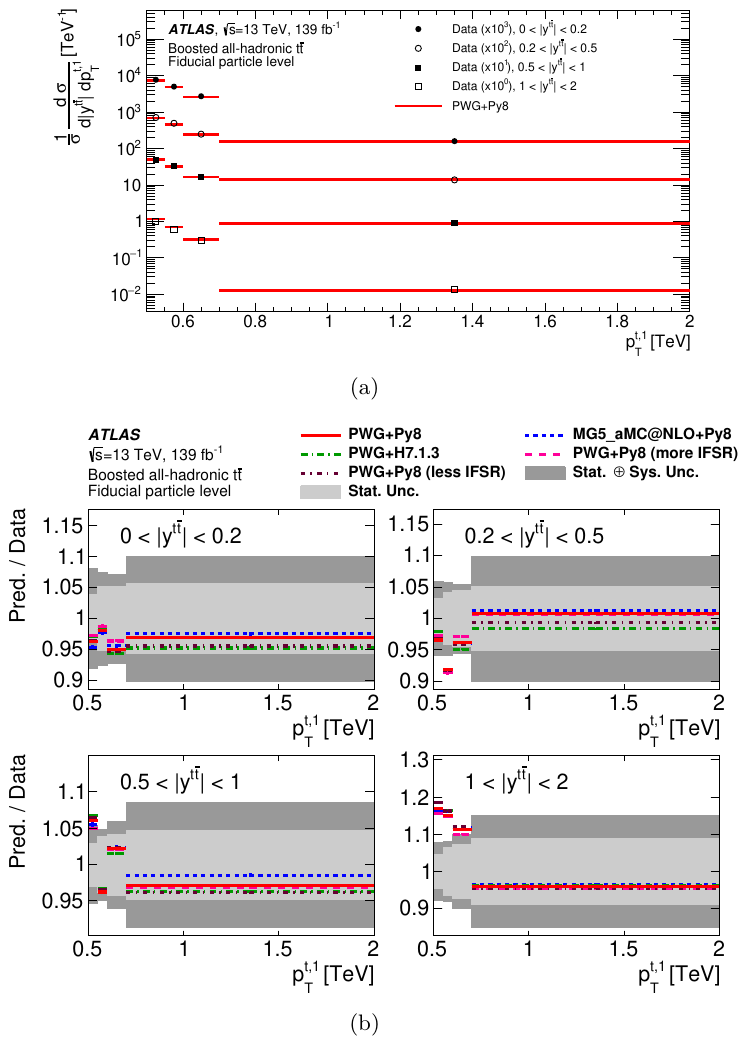
Figure 41 . (a) Normalized particle-level fiducial phase-space double-differential cross-sections as a function of the absolute value of the rapidity of the t ¯ t final state and the transverse momentum of the leading top-quark jet, compared with the Powheg+Pythia 8 calculation. Data points are placed at the centre of each bin and the Powheg+Pythia 8 calculation is indicated by solid lines. The measurement and the prediction are normalized by the factors shown in parentheses to aid visibility. (b) The ratios of various MC calculations to the normalized particle-level fiducial phase- space differential cross-sections. The dark and light grey bands indicate the total uncertainty and the statistical uncertainty, respectively, of the data in each